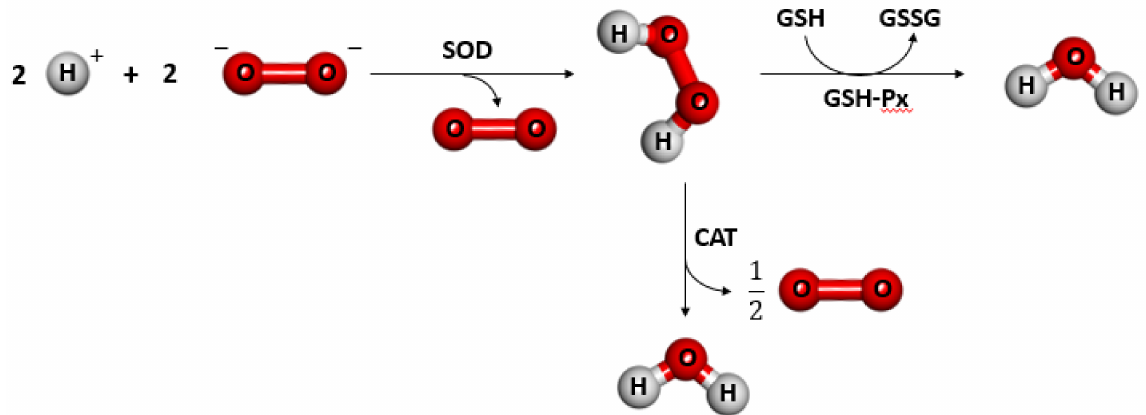
Figure 2. The principle of antioxidant action. SOD (superoxide dismutase), CAT (catalase), GSH-Px (glutathione peroxidase), GSH (reduced glutathione), GSSG (oxidized